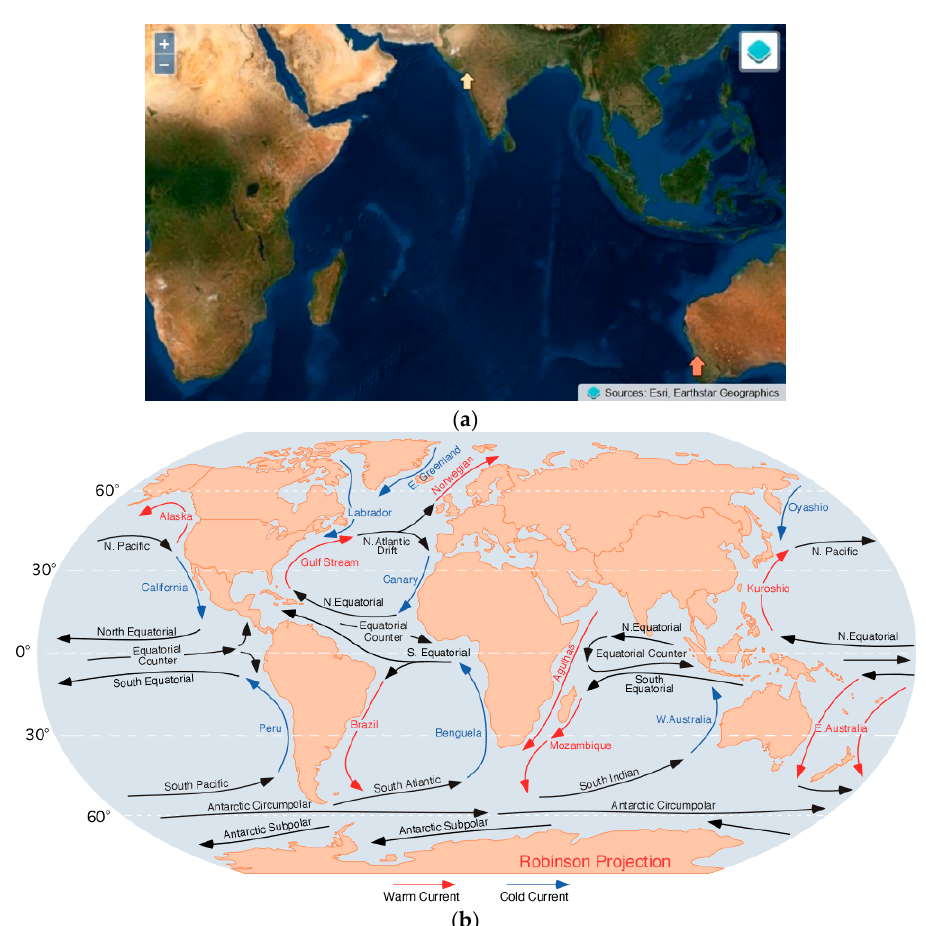
Figure 2. ( a ) Satellite image of the ocean basin under study. Image reproduced and modified from www.psmsl.org / products / trends / . Warm and cold major currents for the area. ( b ) Image reproduced www.psmsl.org/products/trends/. Warm and cold major currents for the area. ( b ) Image reproduced and modified from https: // en.wikipedia.org / wiki / Ocean_current# / media / and modified from https://en.wikipedia.org/wiki/Ocean_current#/media/File:Corrientes- oceanicas.png.